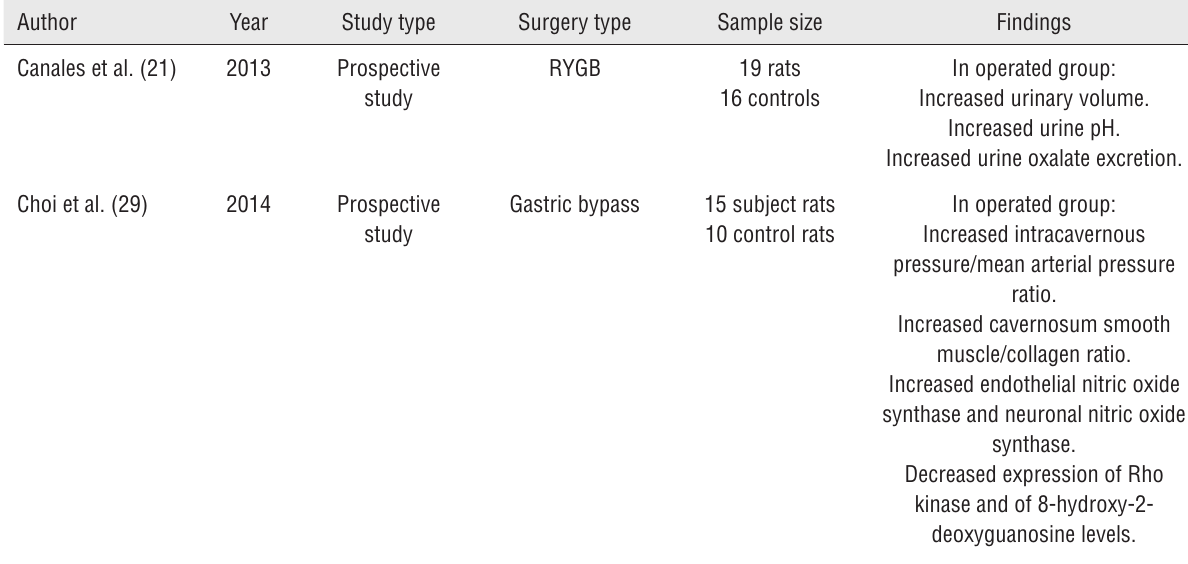
Table 2 - Animal studies about changes in urinary profile after bariatric